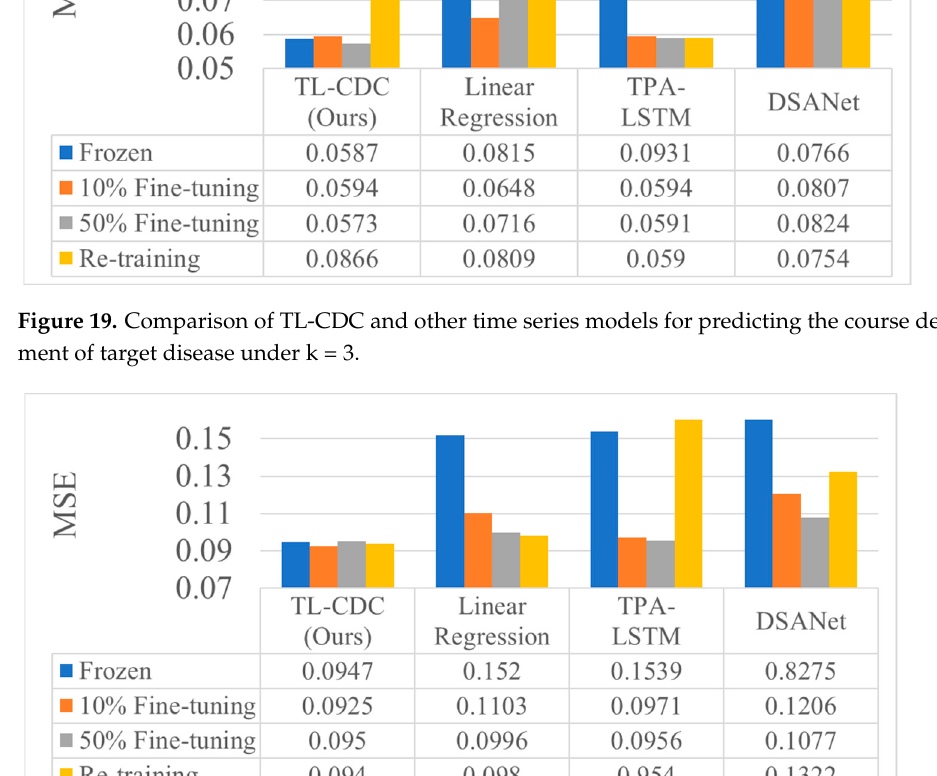
Figure 20. Comparison of TL-CDC and other time series models for predicting the course develop- ment of target disease under k = 4.